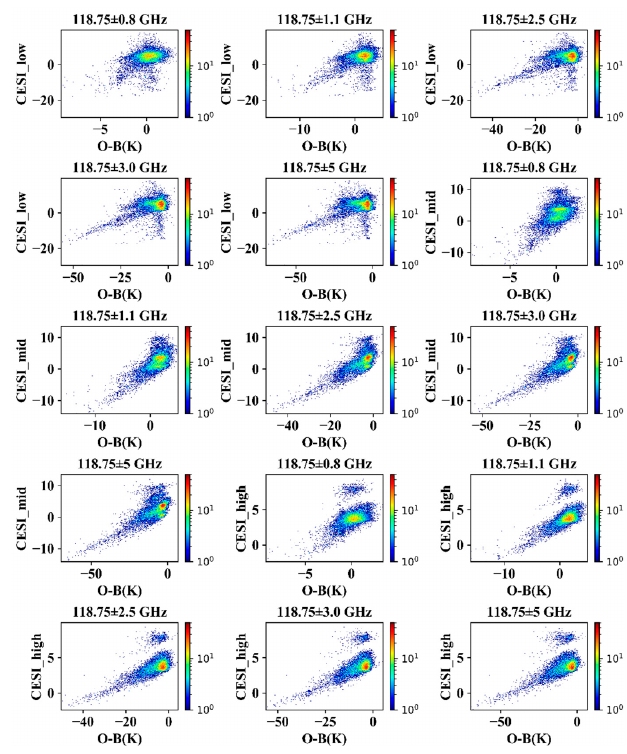
Figure 13. Same as Figure 12 except for the land surface.